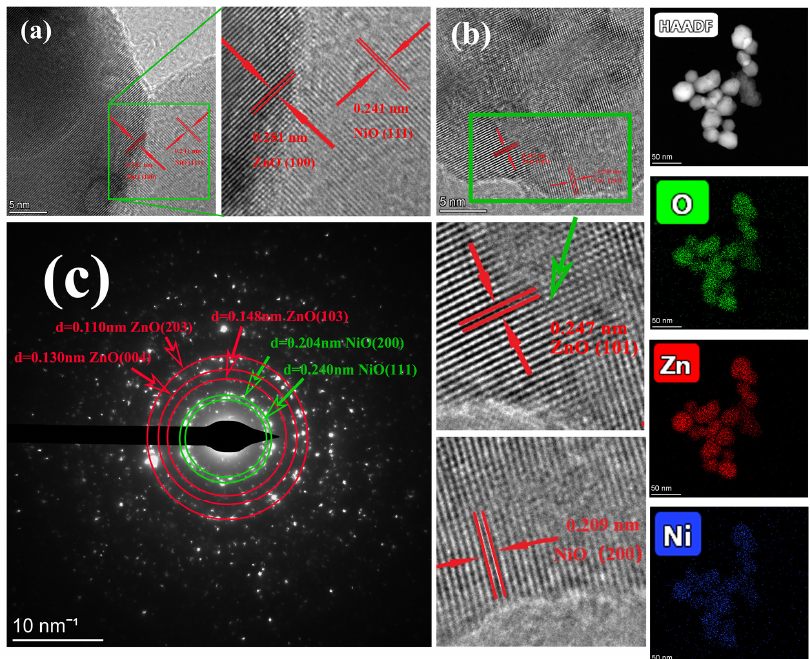
Figure 5. HRTEM images of ( a , b ) OZN-10; ( c ) SAED images of OZN-10; and TEM-mapping image of Zn (red), Ni (blue) and O (green).